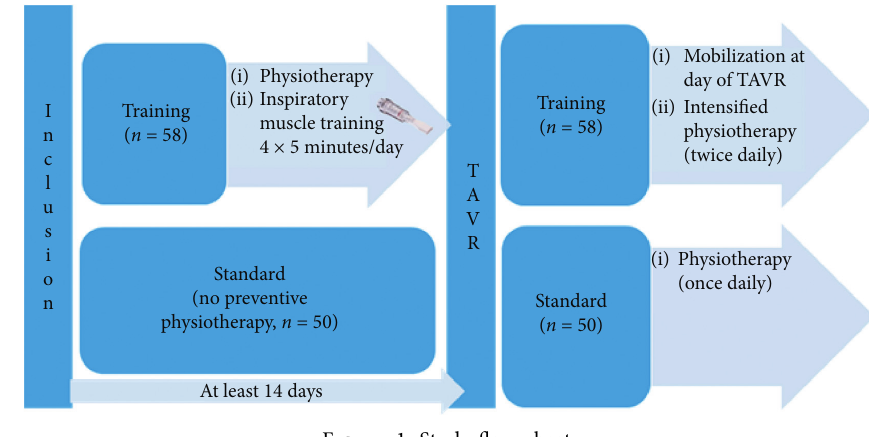
Figure 1: Study flow chart.